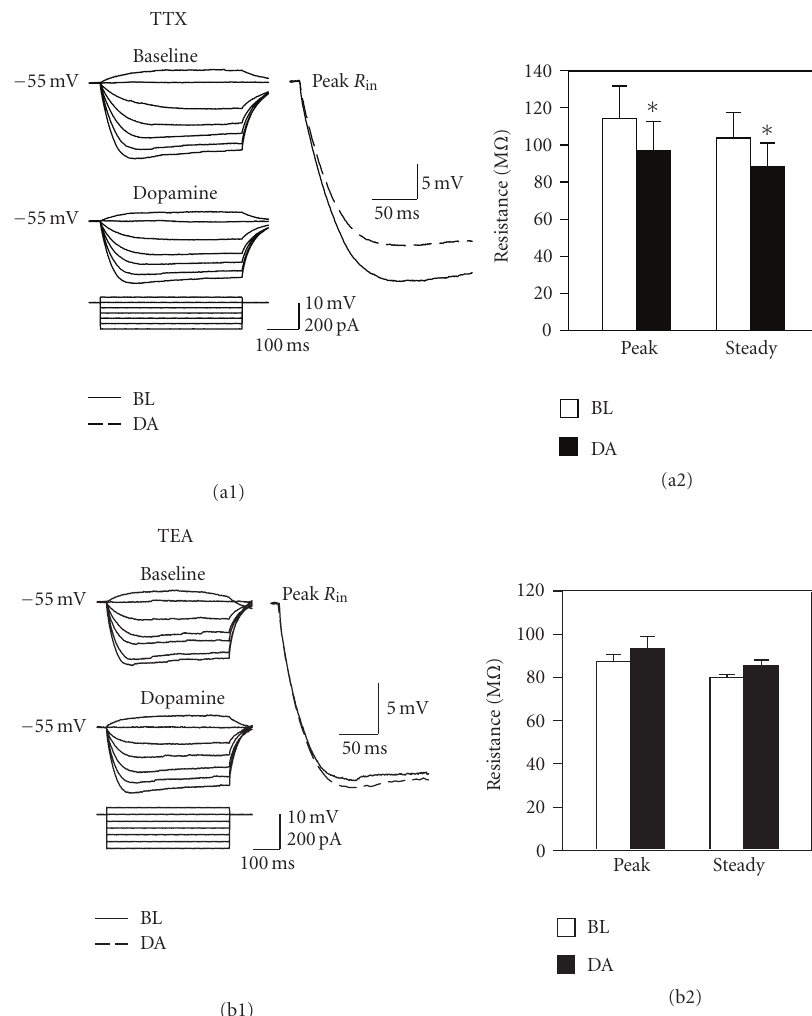
Figure 9: Blocking potassium channels prevent the dopamine-induced reduction in input resistance. (a) Blockade of Na + channels with 0.5 μ M TTX does not prevent the reduction of peak or steady-state input resistance induced by 50 μ M dopamine ( ∗ , P < . 01). Conventions are as in Figure 8. (b) In contrast, coapplication of the K + channel blocker TEA (30mM) prevented the dopamine-induced reduction in input